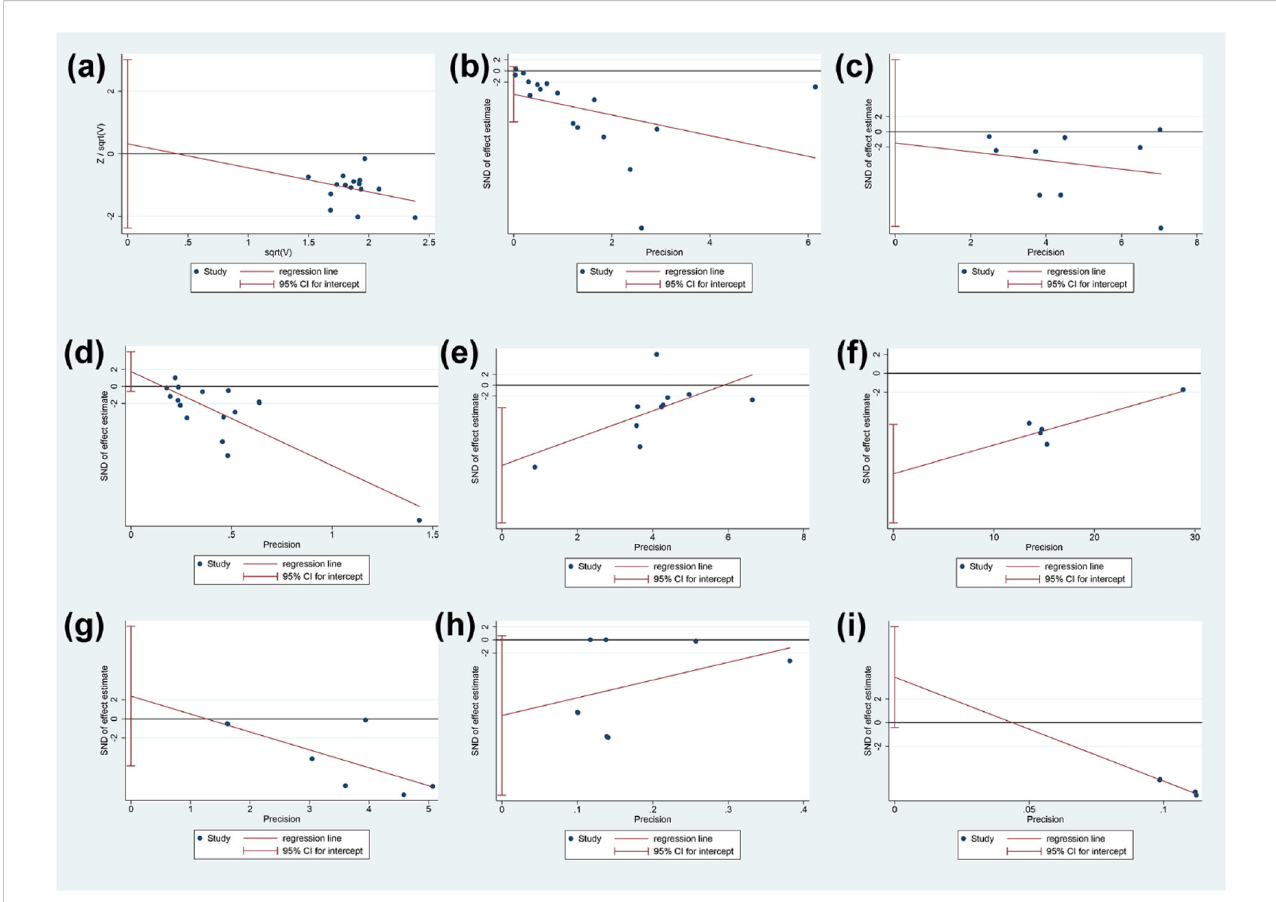
FIGURE 14 Publication bias results (A) adverse events of total glucosides of paeony; (B) CRP of total glucosides of paeony; (C) DAS28 of total glucosides of paeony; (D) ESR of total glucosides of paeony; (E) RF of total glucosides of paeony; (F) CRP of curcumin; (G) DAS28 of curcumin; (H) ESR of curcumin; (I) RF of